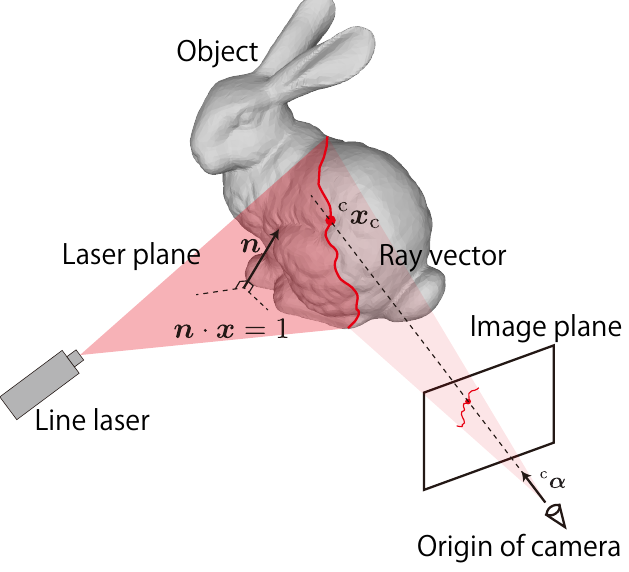
Figure 4. Principle of light-section